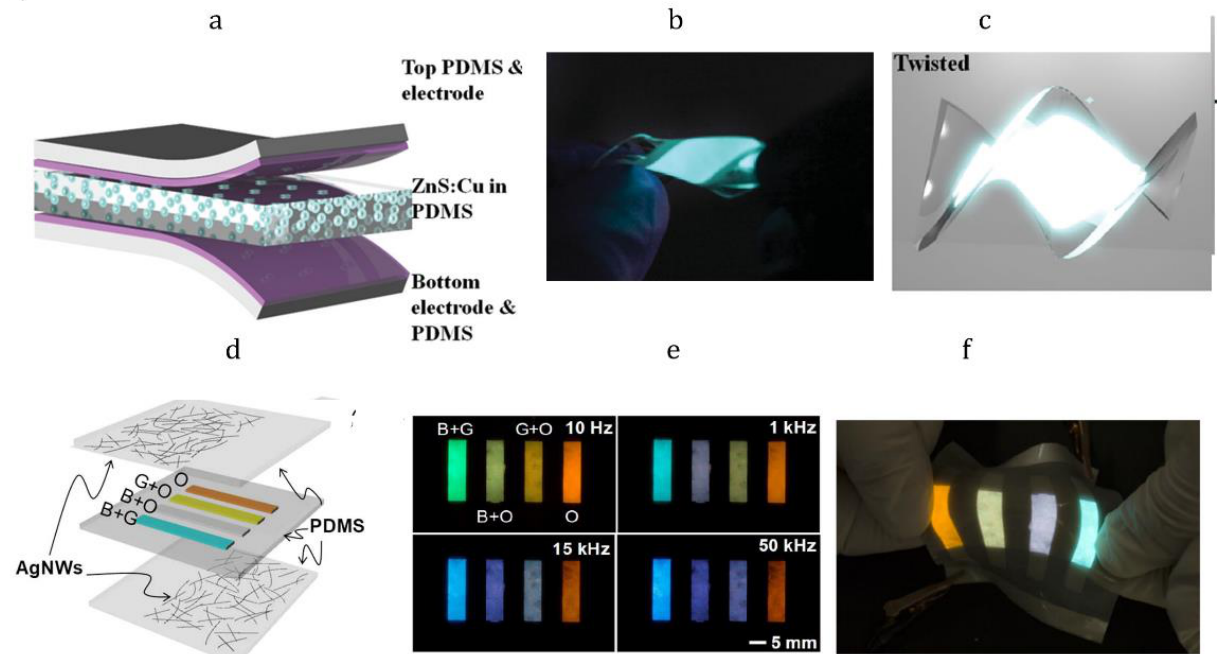
Figure 7. Blue ACELs architecture ( a ), optical image of blue twisted ACEL with ( b ) and without ( c ) applied voltage. Reproduced with permission [31]. Copyright 2015, Wiley-VCH. Colorful ACEL ar- chitecture ( d ) optical image of colorful ACEL under applied voltage ( e ) and stretched ( f ). Repro- duced with permission [33] Copyright 2018, Nature Publishing Group.